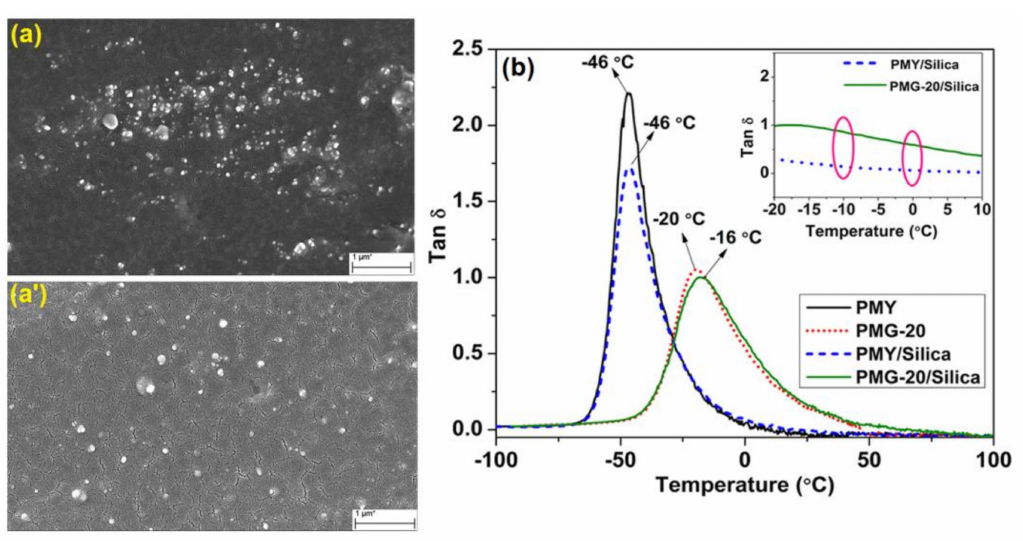
Figure 9. SEM images of ( a , a’ ) PMY / silica and PMG-20 / silica nanocomposite. ( b ) Tan δ vs. temperature plot of pristine and silica vulcanizates. Sample designations: ‘PMY’ stands for polymyrcene; ‘PMG-20’ represents copolymer containing 20 wt% GMA, PMY / Silica; and ‘PMG-20 / Silica’ indicates silica nanocomposites. (Reproduced from Ref. 53, with permission from American Chemical